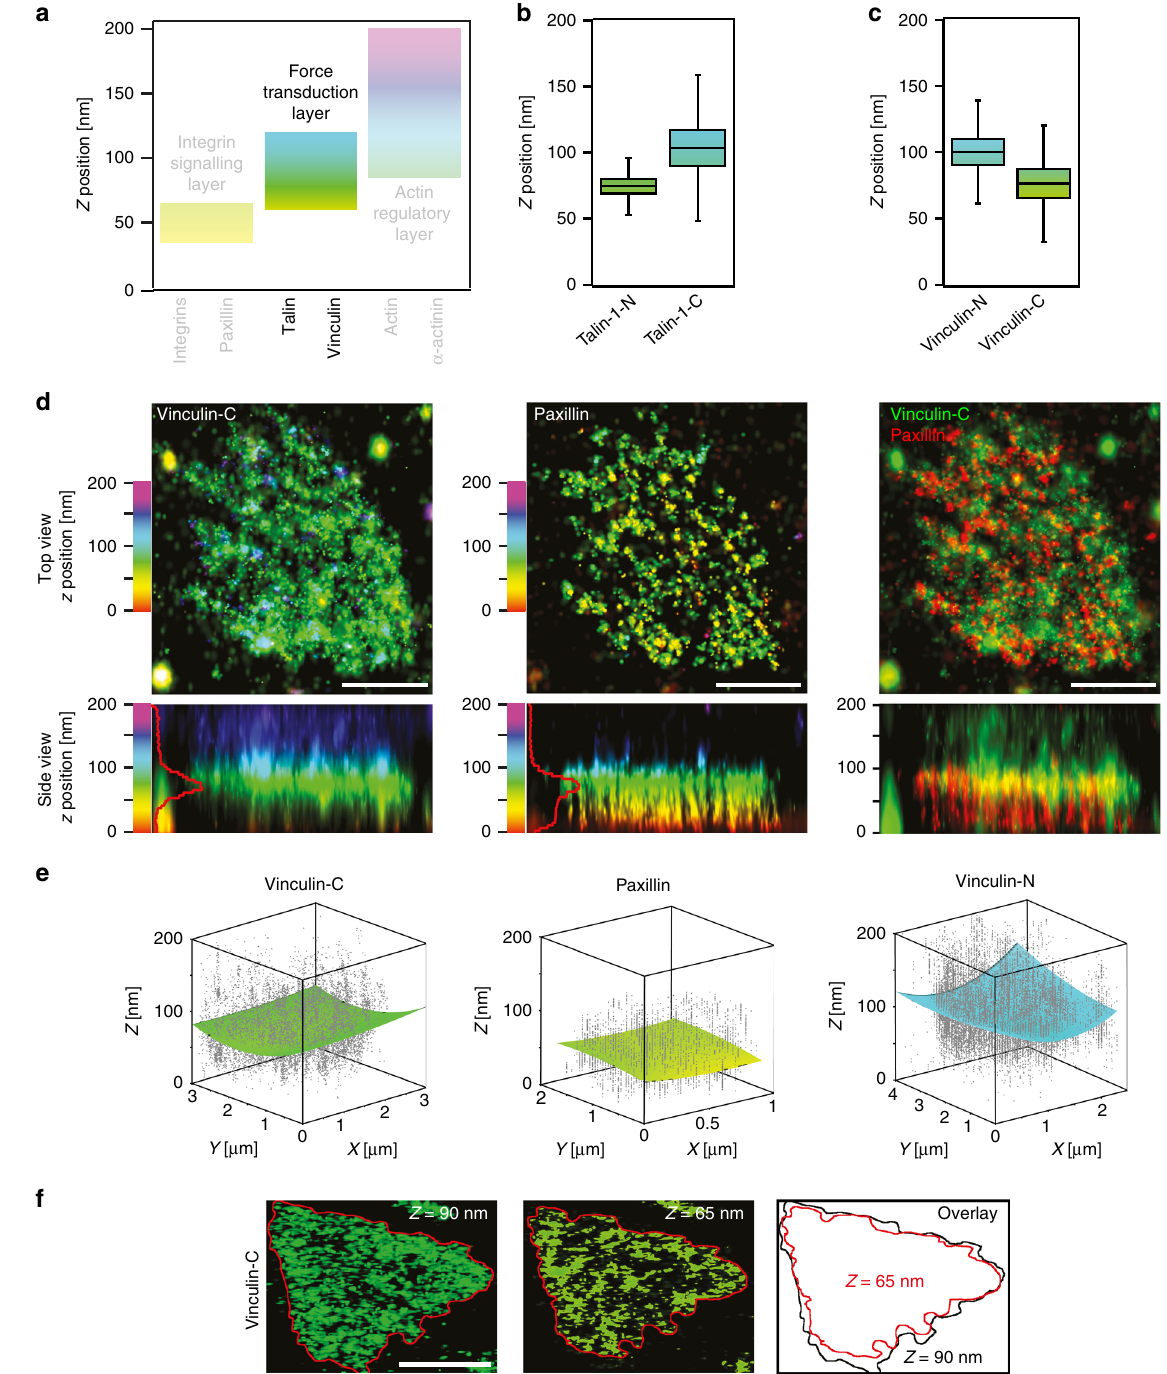
kank2 adjacent to FA were Z centre = 116.1 ± 12.1 nm and Z centre = 100.8 ± 13.4 nm and for FA-distal kank1 and kank2, Z 63.4 ± 13.6 nm and Z centre = 74.2 ± 17.7 nm, respectively (Fig.